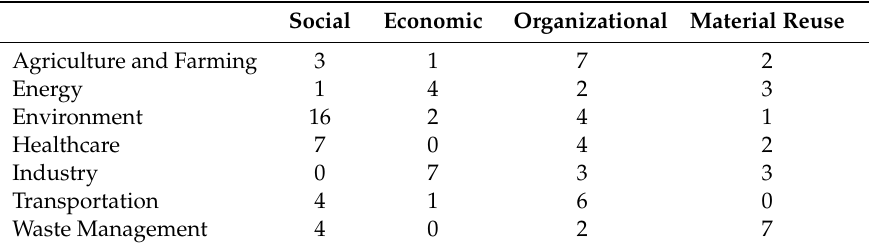
Table 18. Impact of IoT-LoRa proposals on circular economy of smart